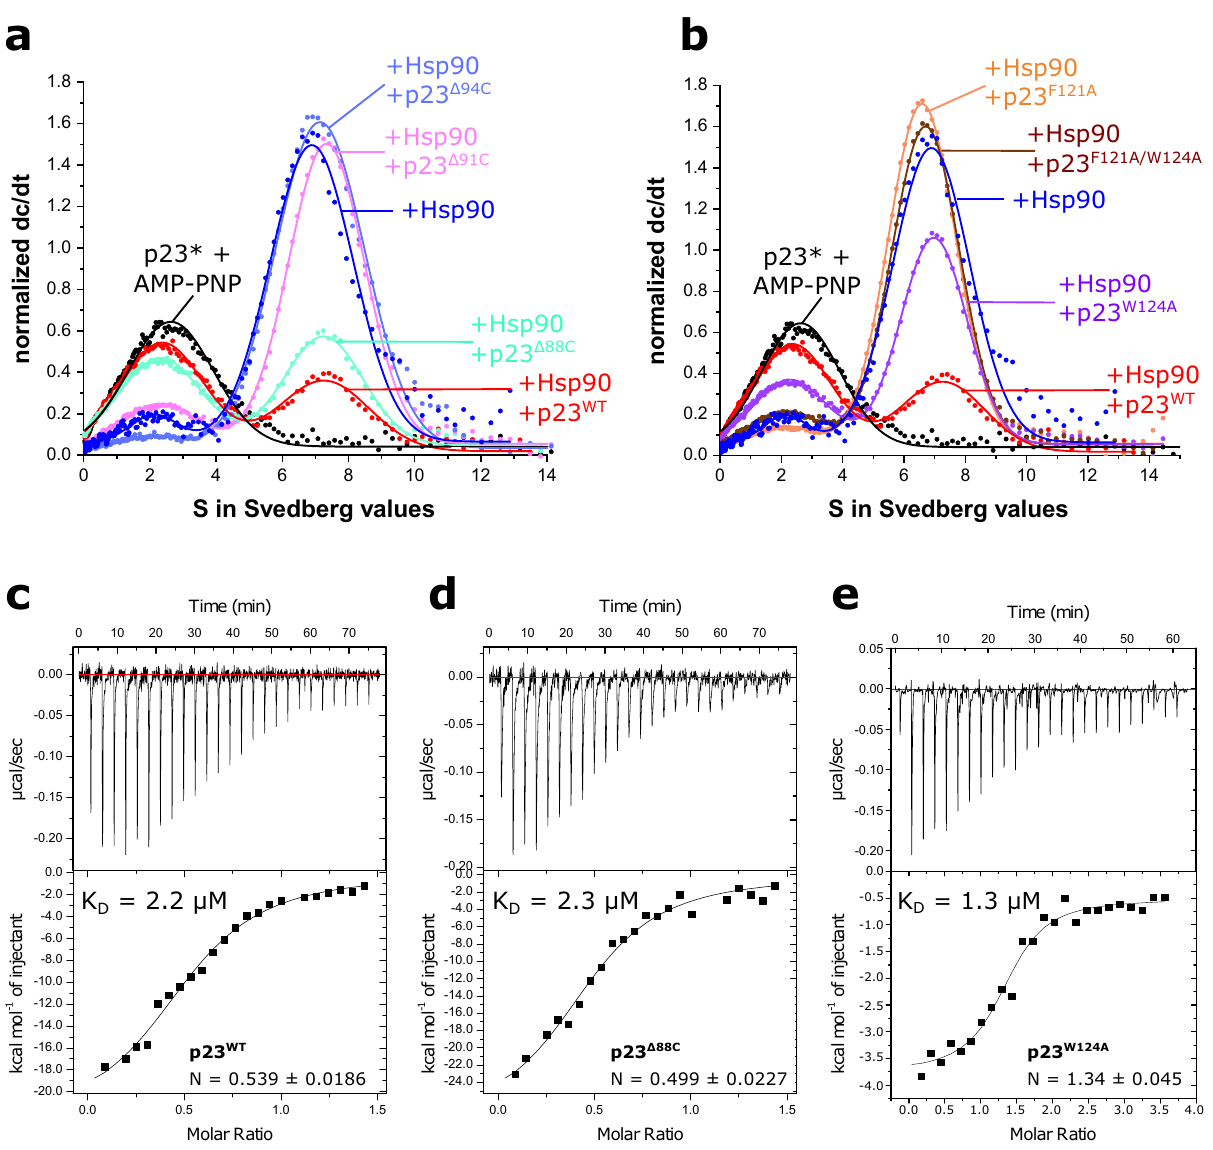
Fig. 2 Analysis of the binding of p23 to Hsp90. a , b Analytical ultracentrifugation analysis of the binding between yeast Hsp90 (Hsp82) and yeast p23 (Sba1) mutants. All measurements were performed in the presence of 2 mM AMP – PNP. Labeled p23 (p23*) was bound to Hsp90 and an excess of the depicted p23 mutants was added. c – e Isothermal titration calorimetry analysis of the af fi nity between yeast ( c ) p23 WT , ( d ) p23 Δ 88 and ( e ) p23 W124A and yeast Hsp90 (Hsp82). The measurements were performed in the presence of AMP – PNP. The shown curves are representatives of at least two replicates.